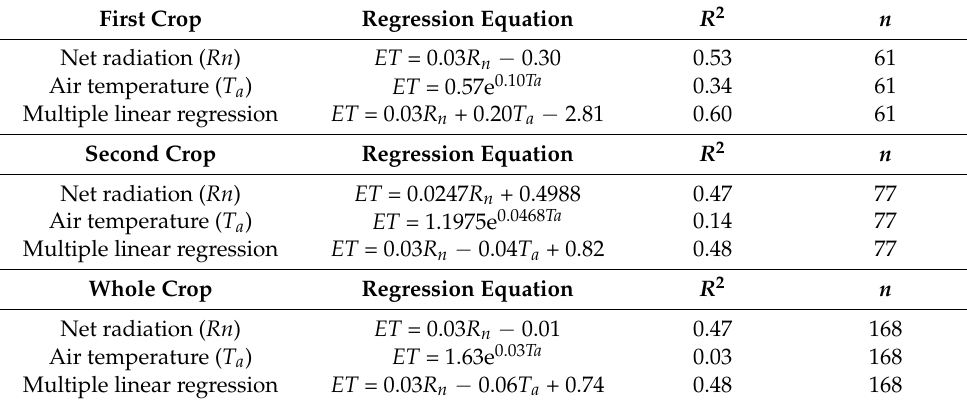
Table 3. Regression analysis between daily ET and its influencing